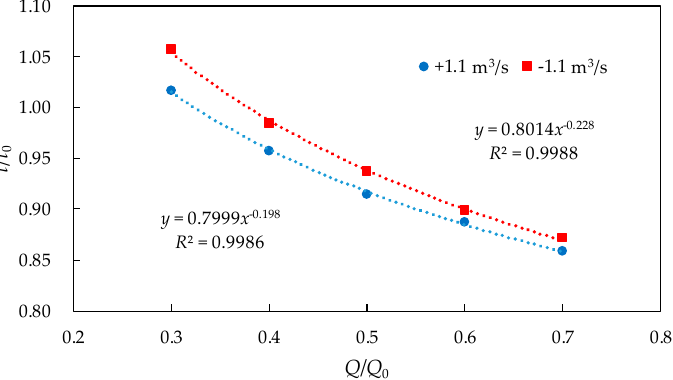
Figure 7. Relationship between Q / Q 0 and t / t 0.